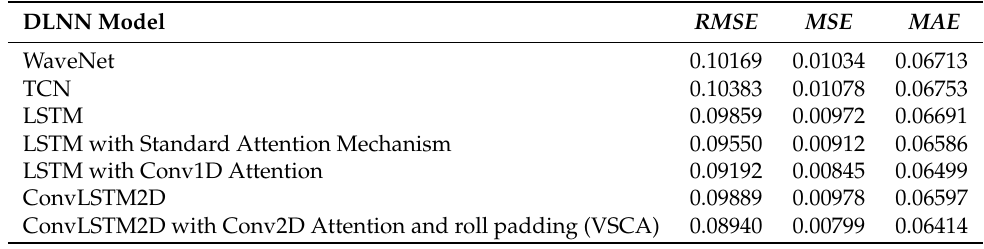
Table 10. Forecasting errors in the test set with normalized output